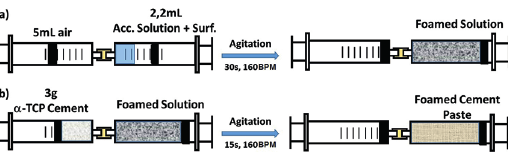
Figure 1: Foaming system, composed by 2 syringes connected by a flexible PVC valve. (a) Foaming of the solution. (b) Obtaining of the foamed cement paste.